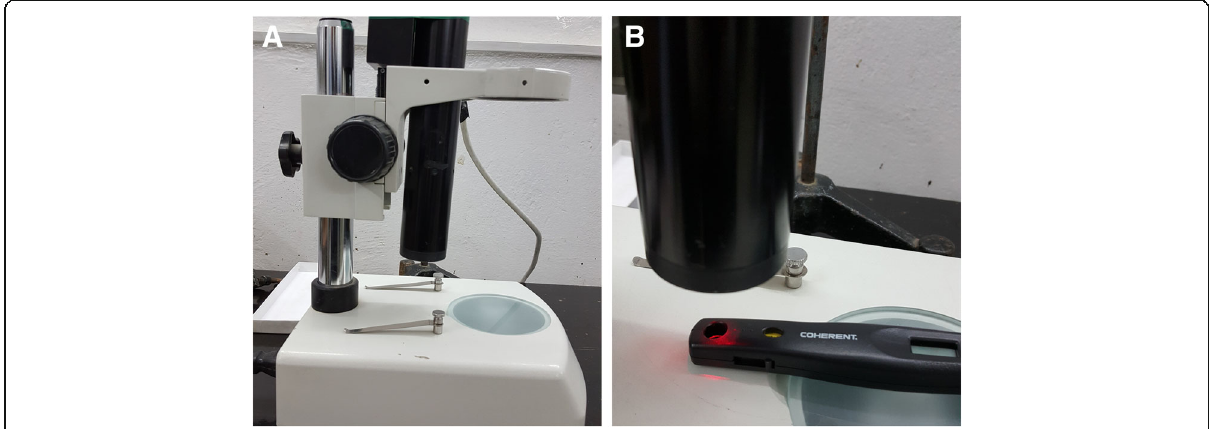
Fig. 1 a The source of laser used in this study was Helium-Neon (He-Ne) gas laser (Model DL30, LG Lasers) with output power approximately 20 mW as a continuous wave irradiation. b The wavelength of light that emitted from this laser and output power were determined by using a portable power meter (LaserCheck, Coherent CA,